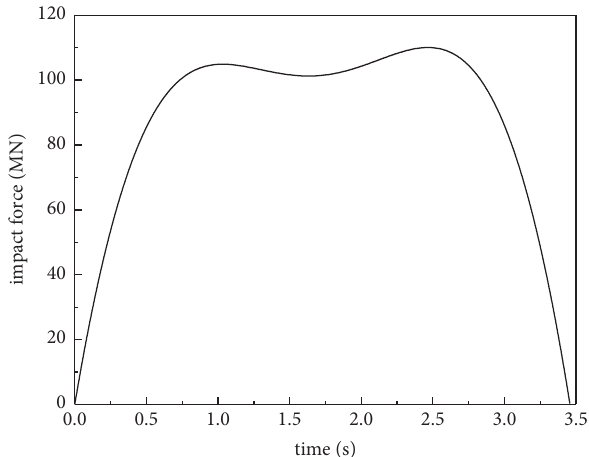
Figure 5: Time-history curve of vessel collision load at DWT � 42500, v � 5.16m/s. Table 5: Boundary and connection conditions of main bridge.